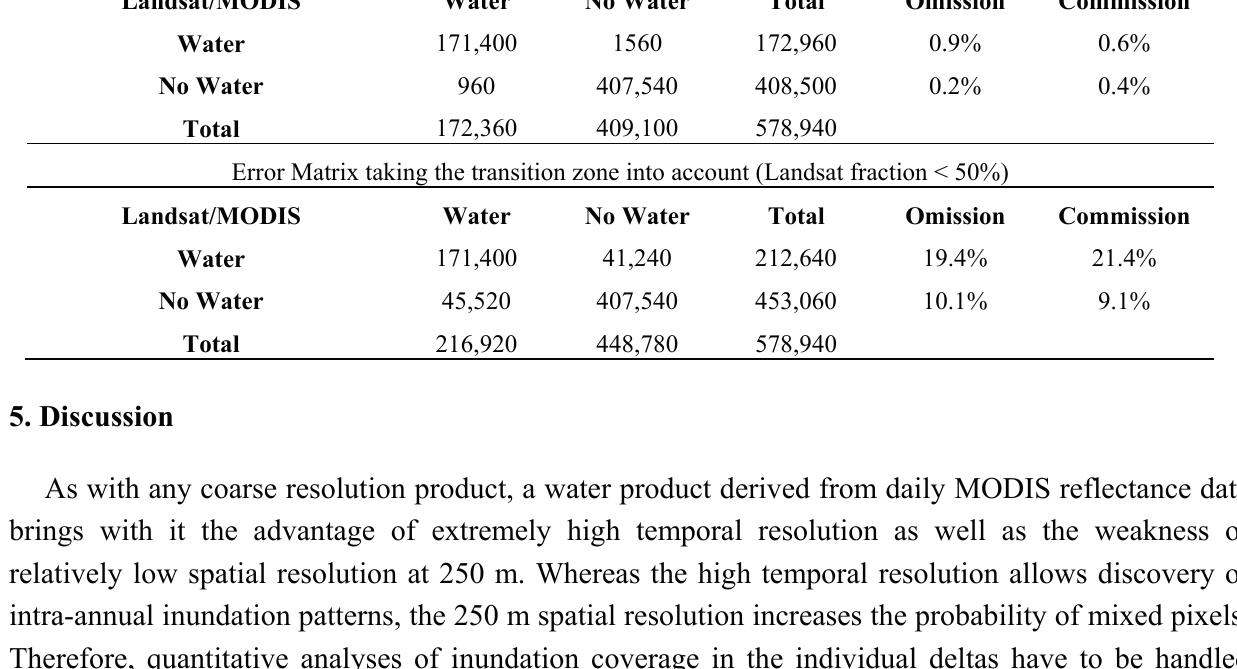
Table 4. Accuracy tables for the Mackenzie Delta Region, year 2013, day of the year 214. Error Matrix Excluding Transition Zone (Landsat Water Fraction > 50%) Landsat/MODIS